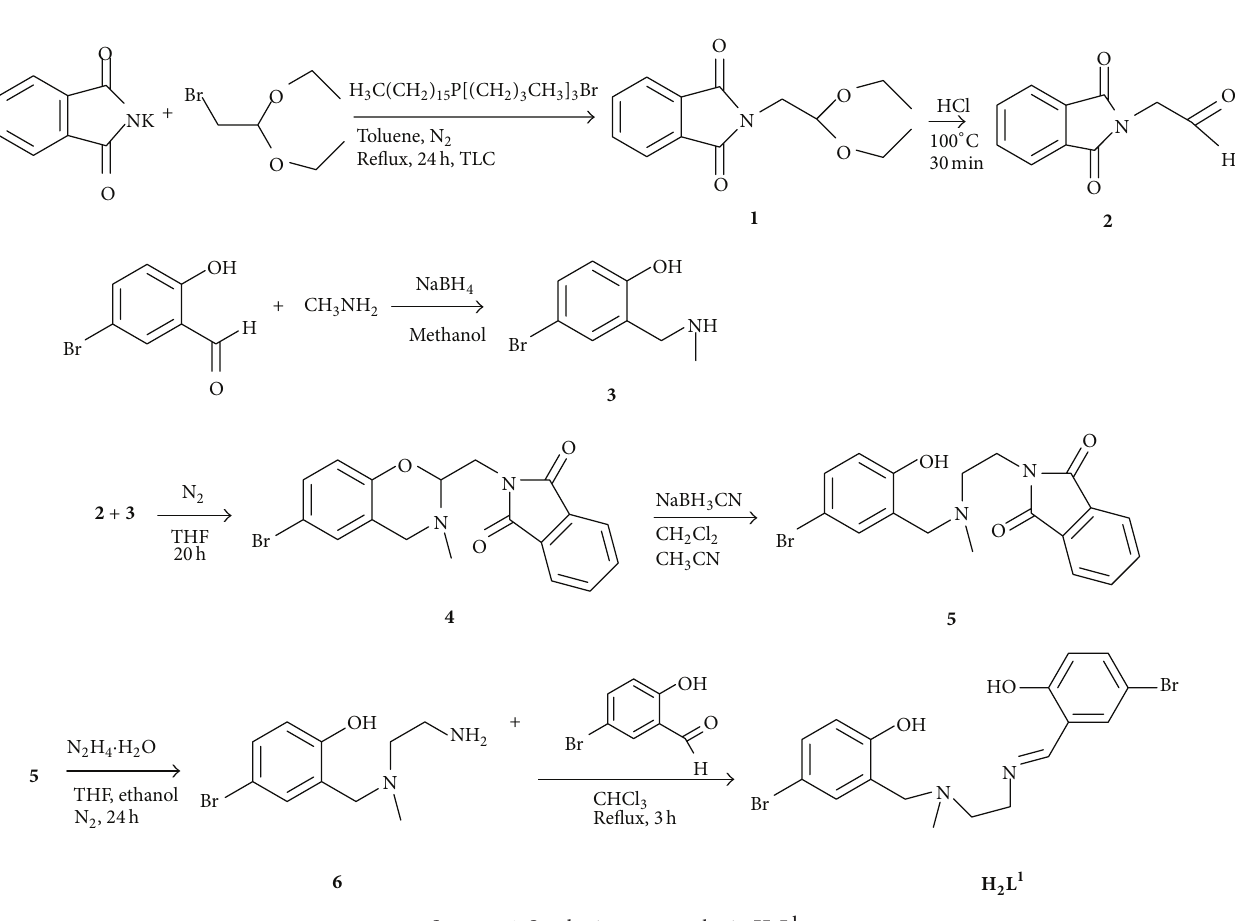
Scheme 1: Synthetic route to obtain H 2 L 1